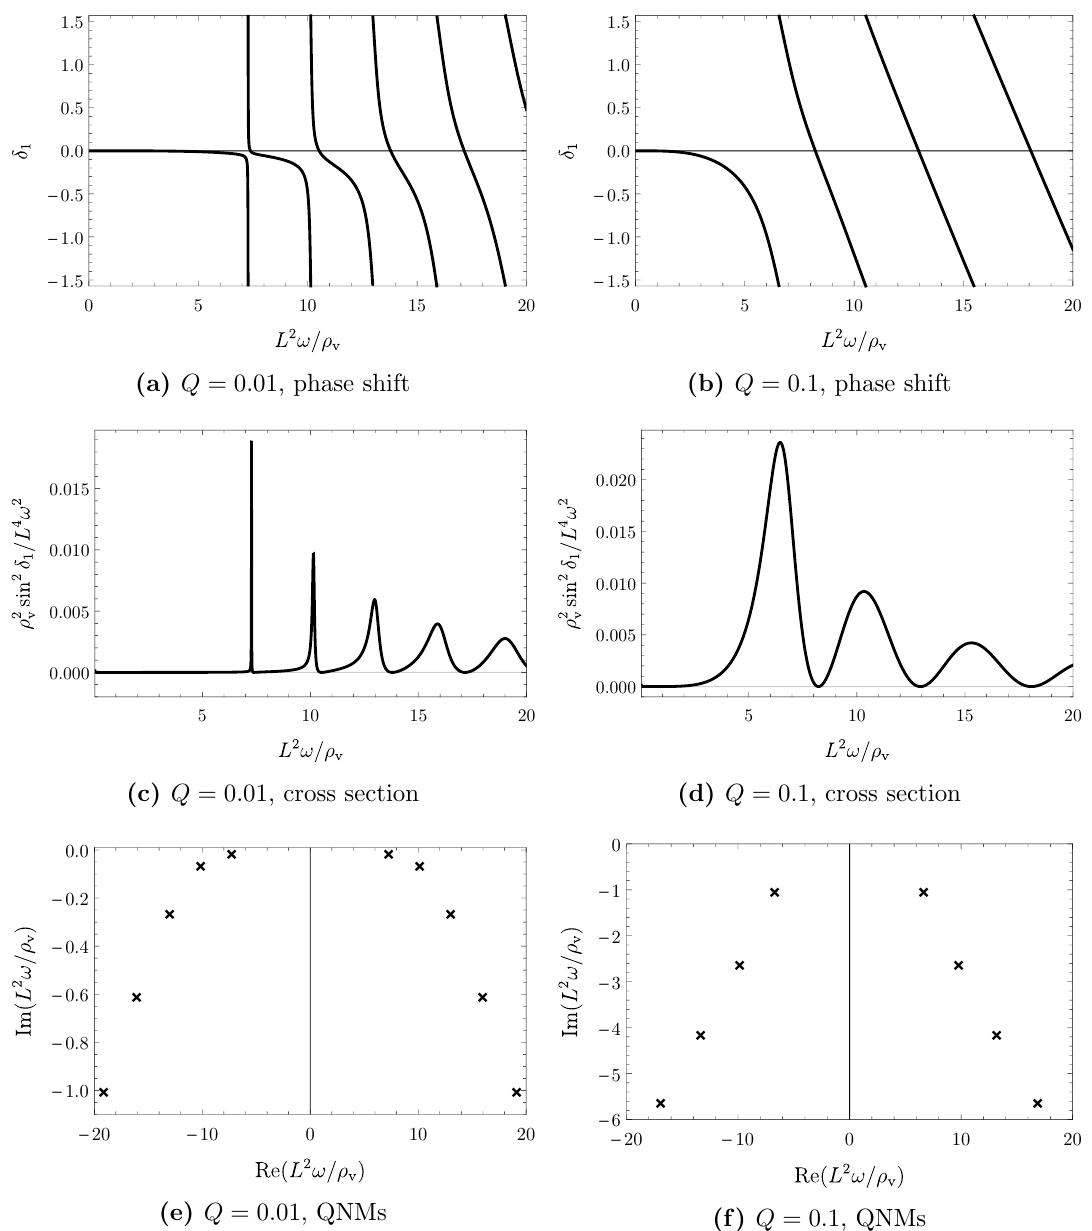
Figure 11. (a) and (b) The phase shift (cid:14) 1 for the (cid:13)uctuation B l with l = 1 as a function of real-valued frequency ! for Q = 0 : 01 and 0 : 1. (c) and (d) The associated cross section sin 2 ( (cid:14) 1 ) =! 2 , in units of L 4 =(cid:26) 2 , as a function of real-valued frequency ! , for Q = 0 : 01 and 0 : 1. (e) and (f) The v complex ! plane, where black crosses denote QNMs of B l with l = 1, for Q = 0 : 01 and 0 : 1 (copied from (cid:12)gure 6). In all plots ! is in units of (cid:26) v =L 2 .